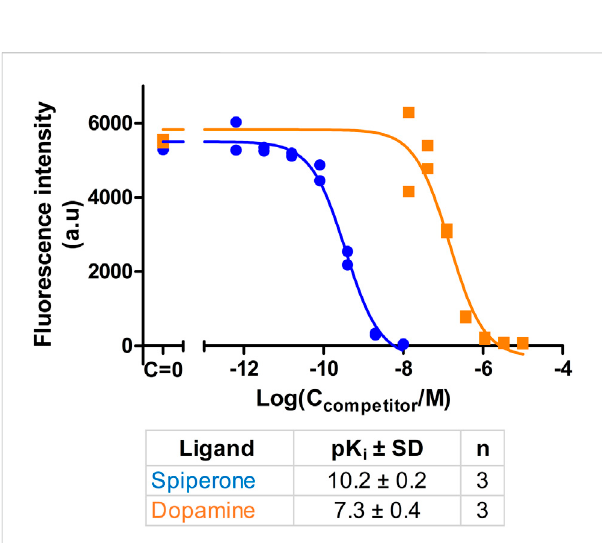
FIGURE 8 Inhibition of CELT-419 binding to live HEK-D3R cells by dopaminergic receptor ligands. The HEK293-D3R cells (40,000 cells/ well) were incubated with 1 nM CELT-419 and different concentrations of Dopamine or Spiperone for 180 min as described in Materials and methods. The background-corrected fl uorescence intensities of cells were determined with the cell detection and image quanti fi cation software as described in Materials and methods and are presented as individual replicates from a representative experiment of three independent experiments performed in duplicates. Every point corresponds to the difference between the average pixel intensity of a cell and the average pixel intensityofthebackground.Theaveragepixelintensitiesofeachpoint were calculated from four images from different fi elds of view obtained from a single